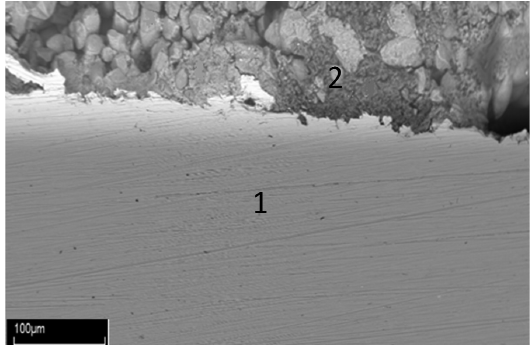
Figure 8. API 5L X80 steel, tested under fully immersed conditions (1% NaCl, pH 6.5, 60 °C), where 1-base metal and 2- Iron Carbonate film.